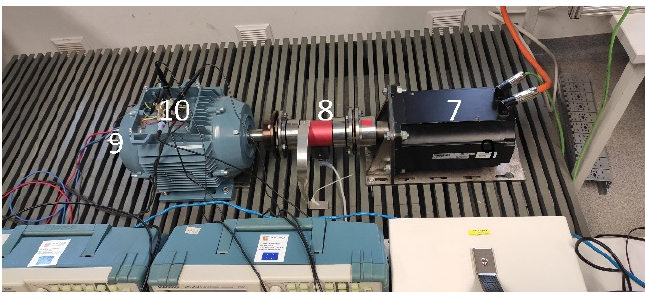
Figure 11. Test stand. Figure 10. Measuring equipment. Figure 10. Measuring equipment. Figure 10. Measuring equipment.